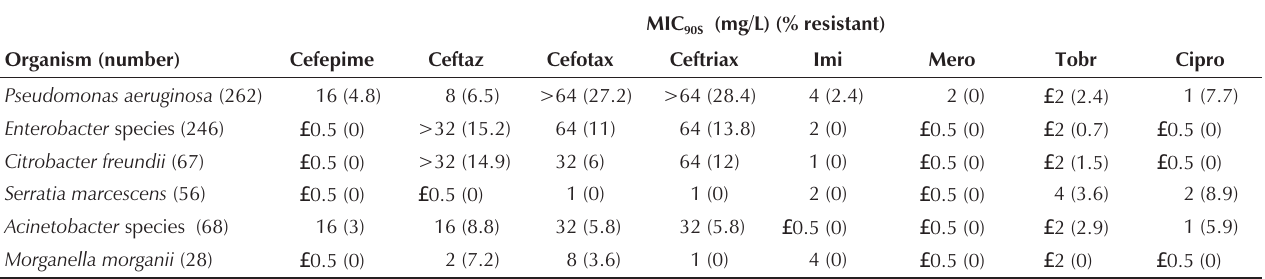
In vitro activity of eight antimicrobial agents against aerobic Gram-negative isolates from across Canada in